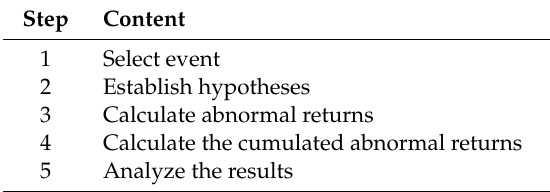
Table 5. Phase model for the systemic execution of an event